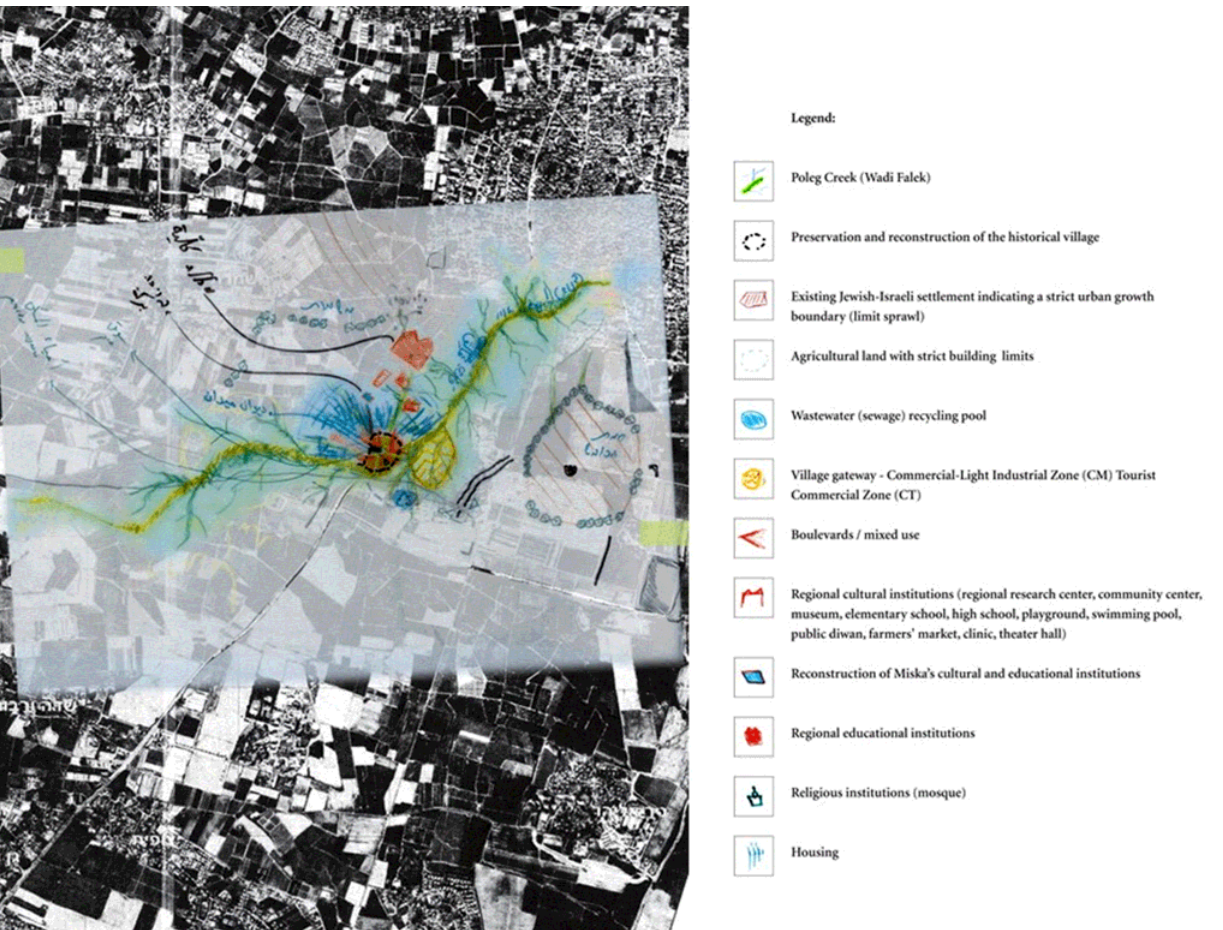
Figure 5. Day 3: Final Map. Super-imposed consensus layers.